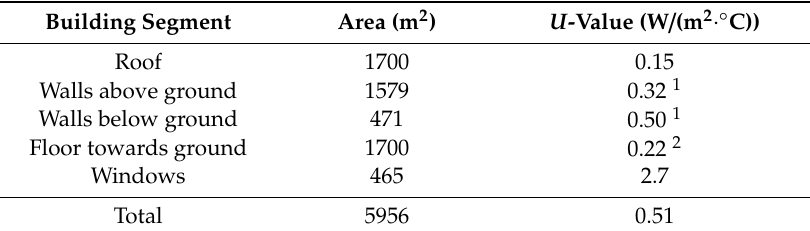
Table 1. Building construction description.